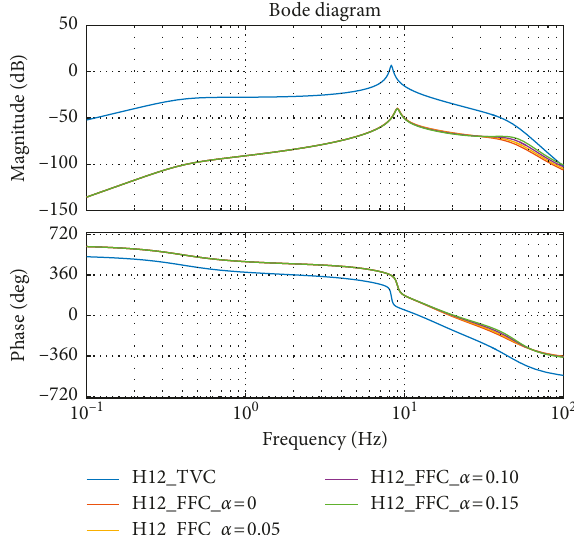
Figure 18: Effect of acceleration sensor error on the Bode diagram of H